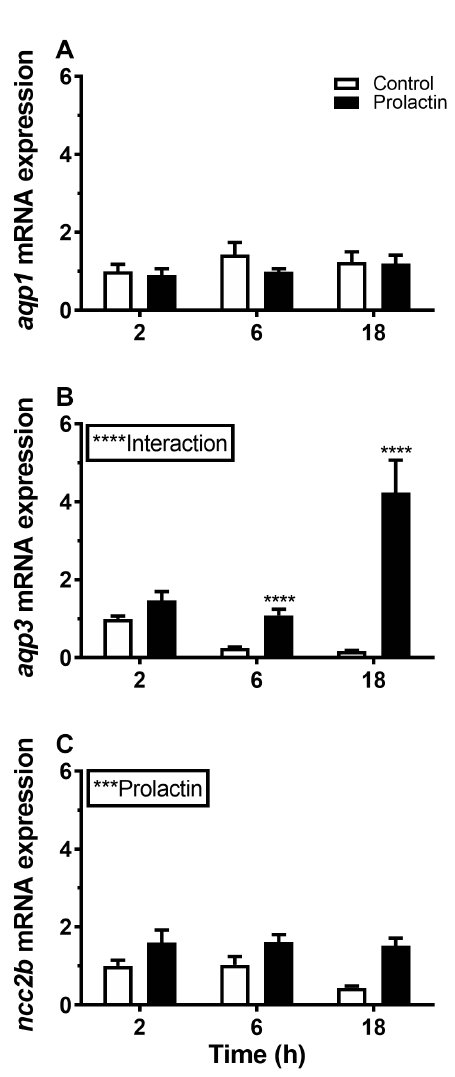
Figure 12. ( A – C ) Ex vivo time-course e ff ect of ovine PRL (1 µ g mL − 1 ) on AQP1 , AQP3 , and NCC2b expression in FW medaka gills. Gill explants were incubated for 2, 6, and 18 h at room temperature. Control incubation (open bars); PRL incubation (solid bars). Expression of each target was normalized to the geometric mean of the three normalization genes: EF1a , bact , and RPL7 and presented relative to the control. Data are presented as mean ± standard error of the mean (n = 7–8). Statistically significant factor e ff ects (two-way ANOVA) are denoted by asterisks next to PRL (*** P < 0.001). When the interaction between the time and prolactin factor was significant, **** P < 0.0001), asterisks were placed above the PRL group to indicate di ff erence from the time-matched control (Sidak multiple comparisons test, **** P <